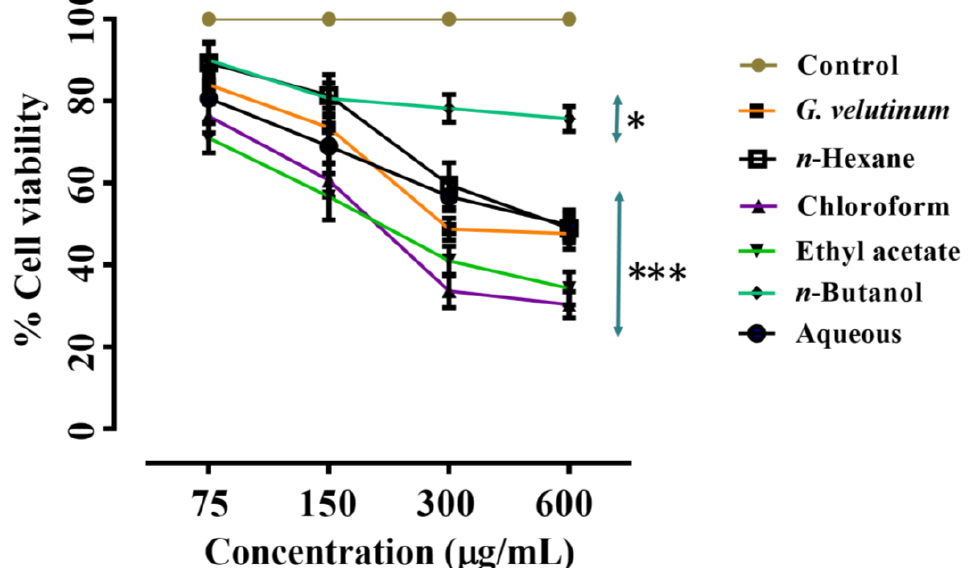
Figure 4. Presentation of growth inhibitory effects of G. velutinum extract and its fractions on PC-3 cells. The results are expressed as a percentage of the negative control. Data are means ± SD of three independent experiments. *** represent p ≤ 0.001.